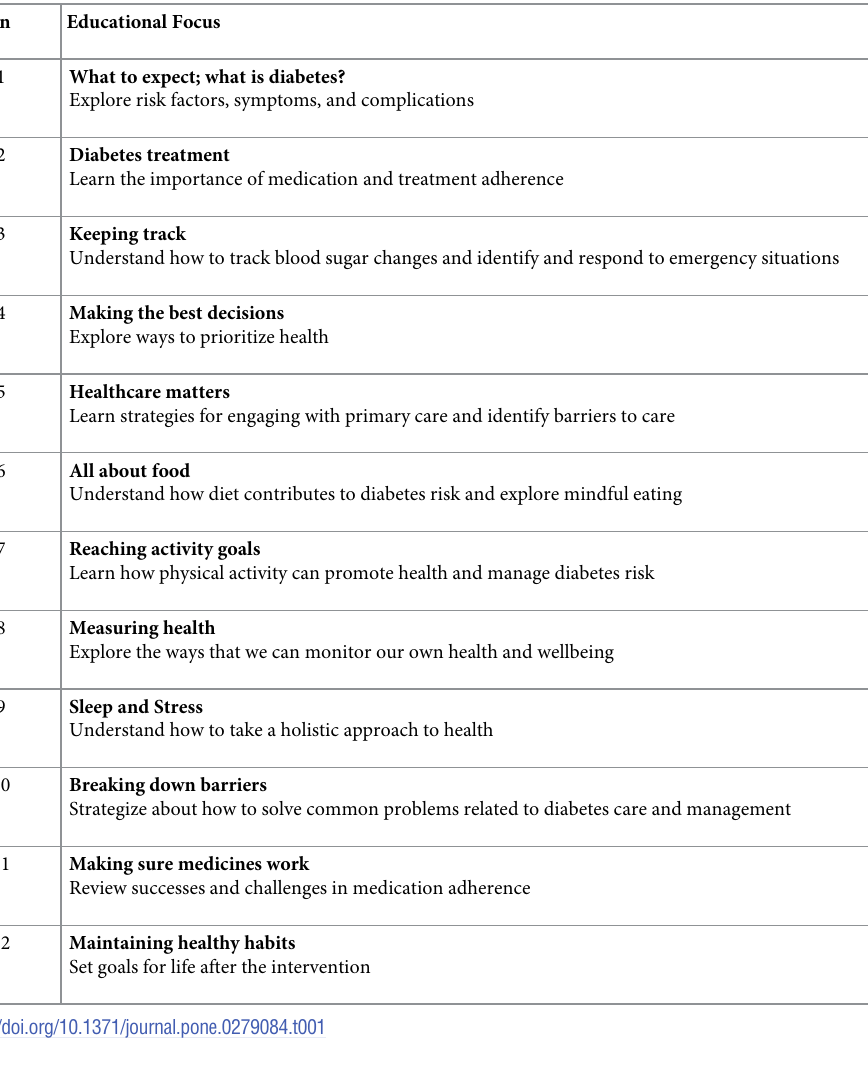
Table 1. Intervention